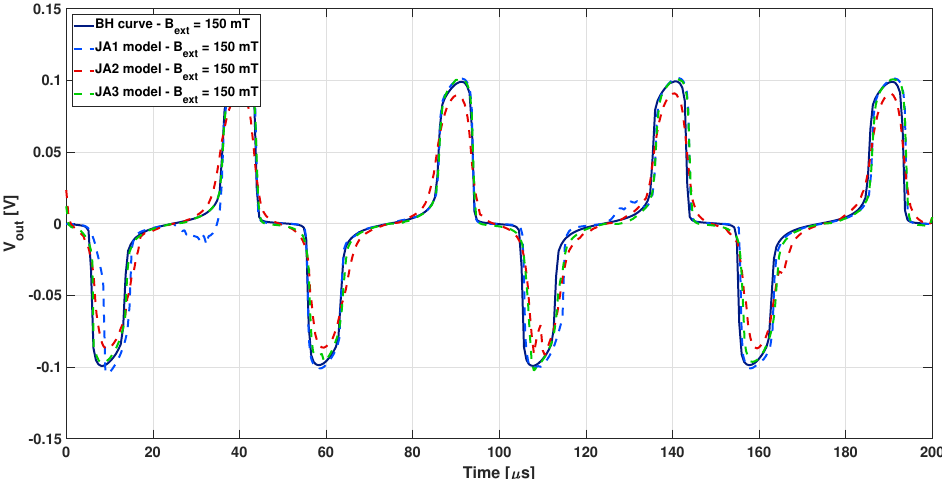
Figure 14. Differential output voltage calculated adopting the Jiles–Atherton model for the JA1, JA2, and JA3 loops (dotted lighter lines) with external magnetic field of 150 µ T), compared to the one calculated without hysteresis (continuous darker